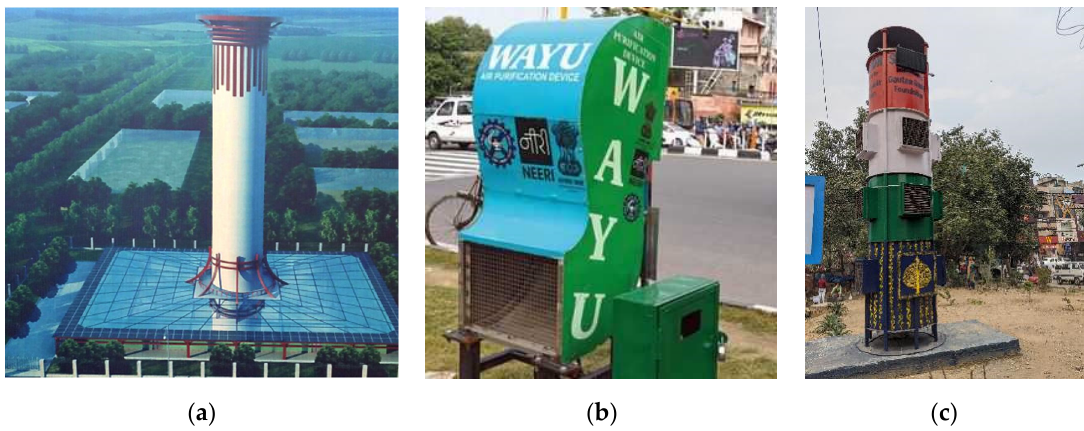
Figure 1. Examples of ambient filtering systems: ( a ) a smog tower from Xi’an, China, (Image edited from South China Morning Post), ( b ) a Wind Augmentation and Air Purifying Unit (WAYU) in Delhi, and ( c ) a smaller version of Xi’an’s filtering system in Delhi.